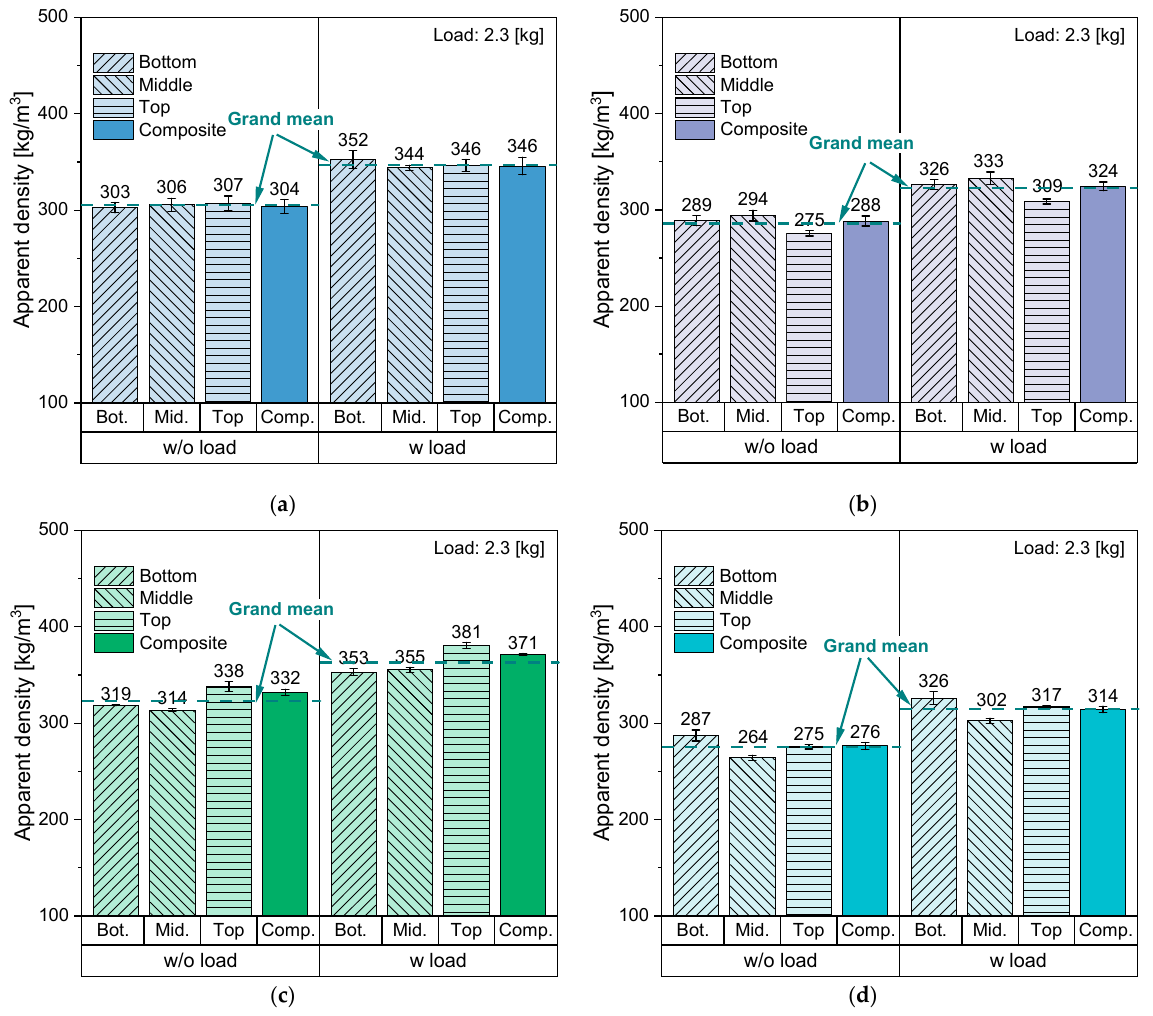
Figure 10. AD values of the individual increment and composite samples of four PO feedstocks without and with weight load based on the test method from ASTM D1895 [82]. ( a ) PP_1, ( b ) PP_2, ( c ) PE-HD_1, ( d ) PE-HD_2. Table 3. Analysis of variance (ANOVA–single factor) within the grouped increment samples of the four PO feedstocks based on AD with a level of significance ( α = 0.05).